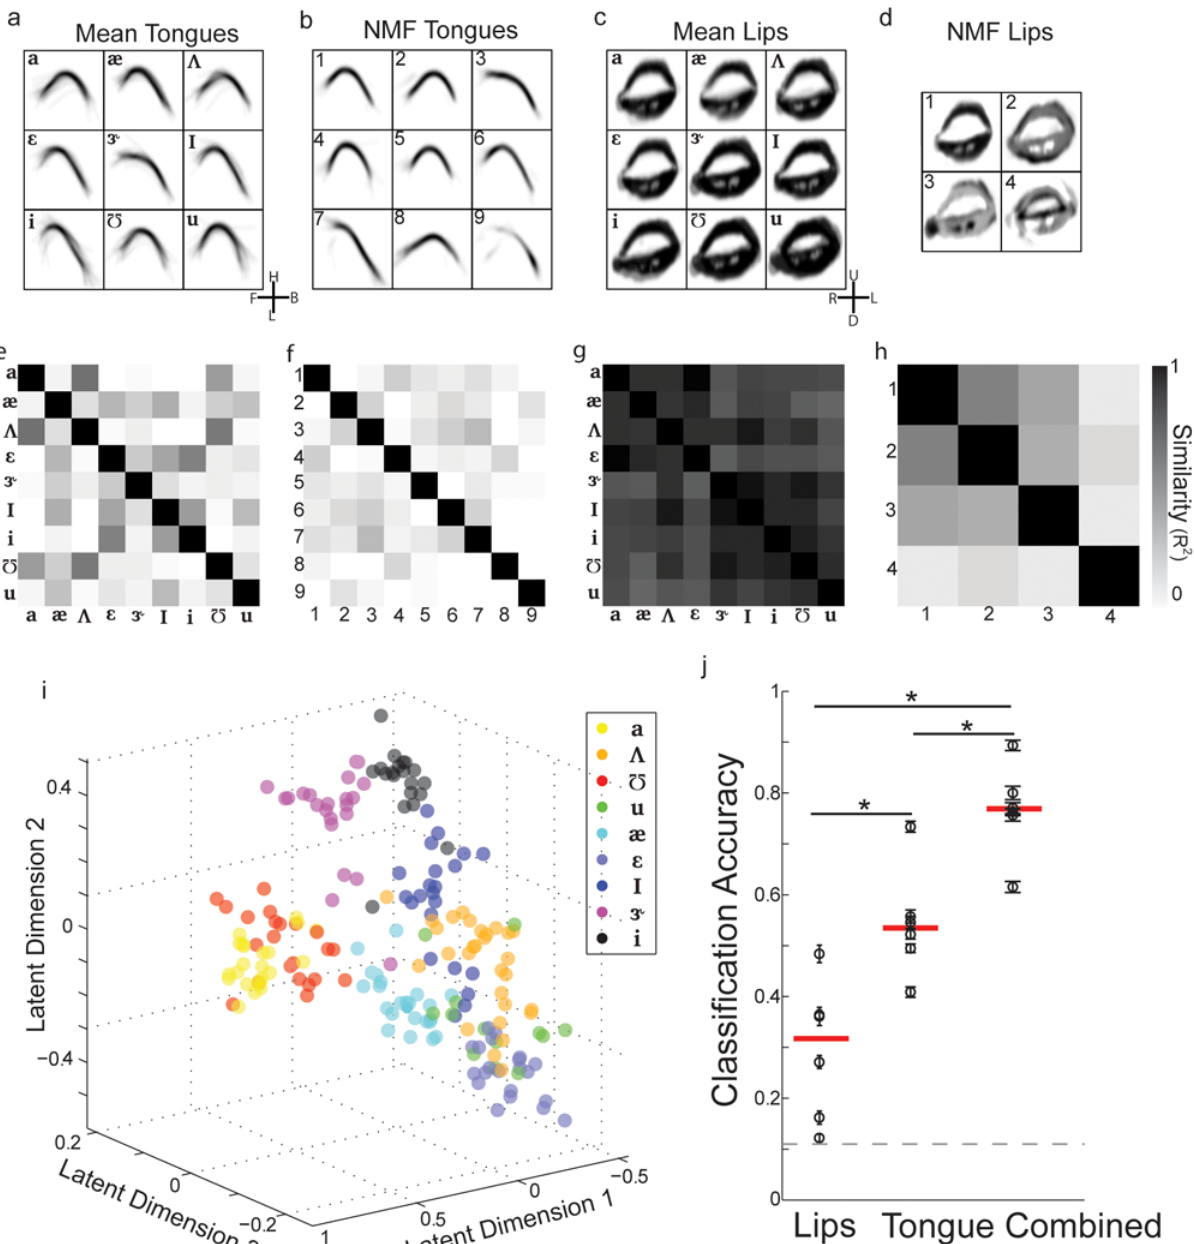
Fig 4. Unsupervised extraction of vocal tract shape with non-negative matrix factorization improves vowel classification. a) Mean tongue shape for each vowel from one subject. b) Non-negative matrix bases blindly extracted from the tongue data for all vowels from one subject. c) Mean lip shape for each vowel from one subject. d) Non-negative matrix bases blindly extracted from the lip data for all vowels from one subject. e-h) Similarity (R 2 ) between mean tongue shapes ( e ), tongue non-negative matrix components ( f ), mean lip shapes ( g ), and lip non-negative matrix components ( h ). i) Scatter plot of all vowels in the first 3 linear discriminant dimensions for one subject (same as Fig 3A – 3D). j) Cross-validated classification accuracy of vowels from vocal tract shapes across all subjects. Na ï ve Bayes classifiers were trained to predict vowel identity based on NMF reconstruction weights for the lips and tongue individually, as well as from both lips and tongue. The combined model out-performs the individual models. Furthermore, the classification accuracy is enhanced relative to using the pre-defined articulatory